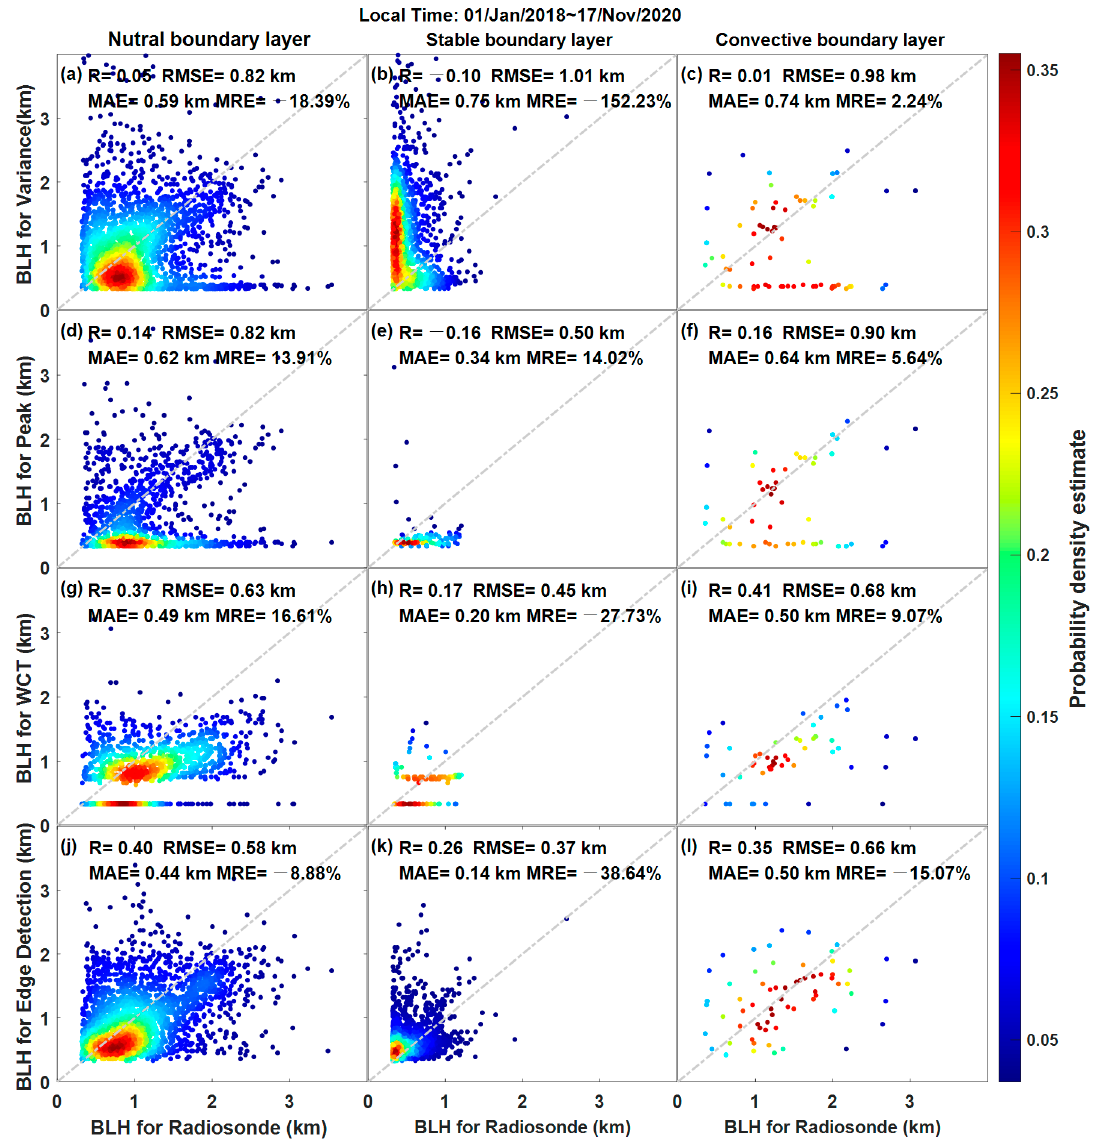
Figure 6. BLHs from 2018 to 2020 obtained using the variance, peak, WCT, and ED methods compared with the RS measurements.